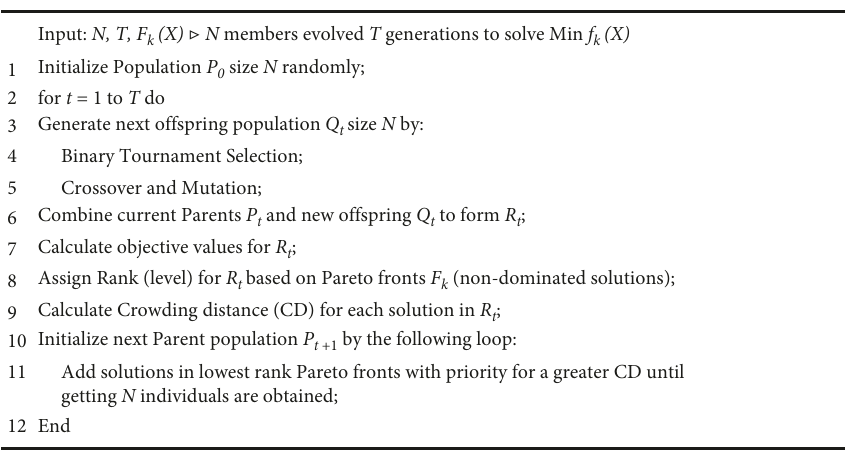
Figure 2: Pseudocode of NSGA-II